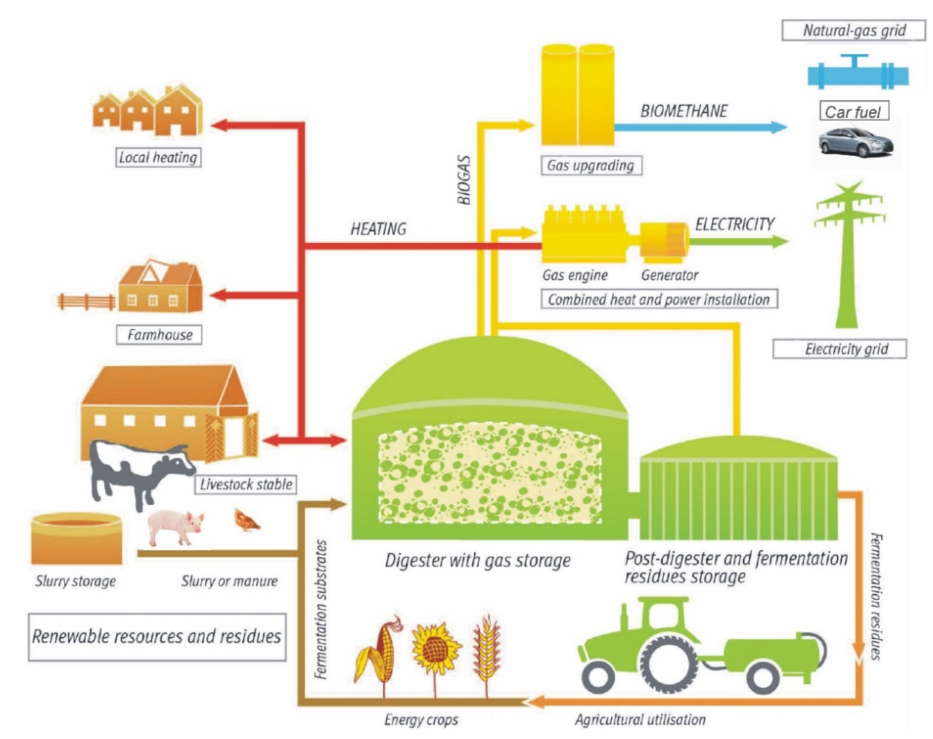
Figure 4. Economic use of BG obtained from biowaste and targeted crops; own elaboration based on [34].